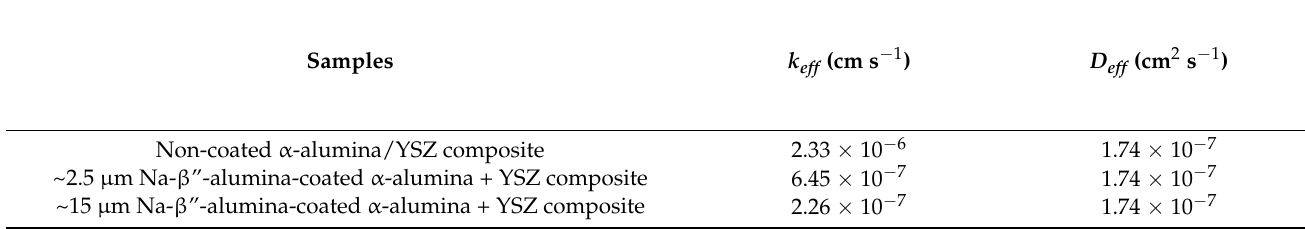
Table 1. Summary of measured k ef f and D ef f for alumina-coated and non-coated samples.